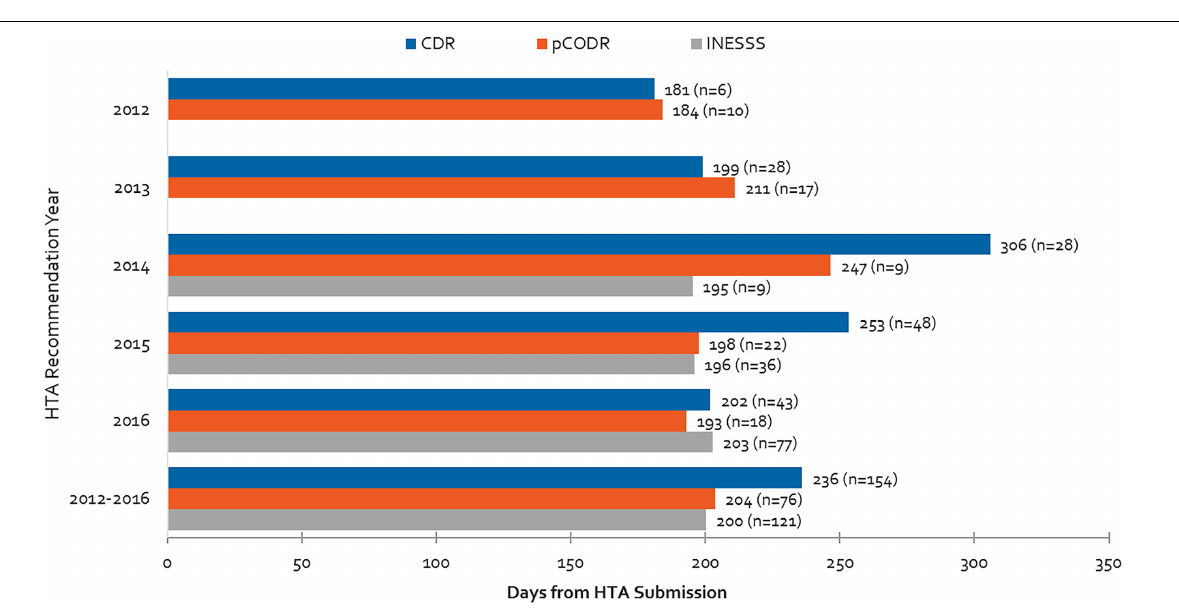
FIGURE 7 | Health Technology Assessment review times for CDR, pCODR and INESSS and number of manufacturer submissions from 2012 to 2016. Data for INESSS represents products with completed recommendations by INESSS that had Health Canada NOCs starting in January 2014. As a result, very few reviews in 2014 are captured (likely starting in October